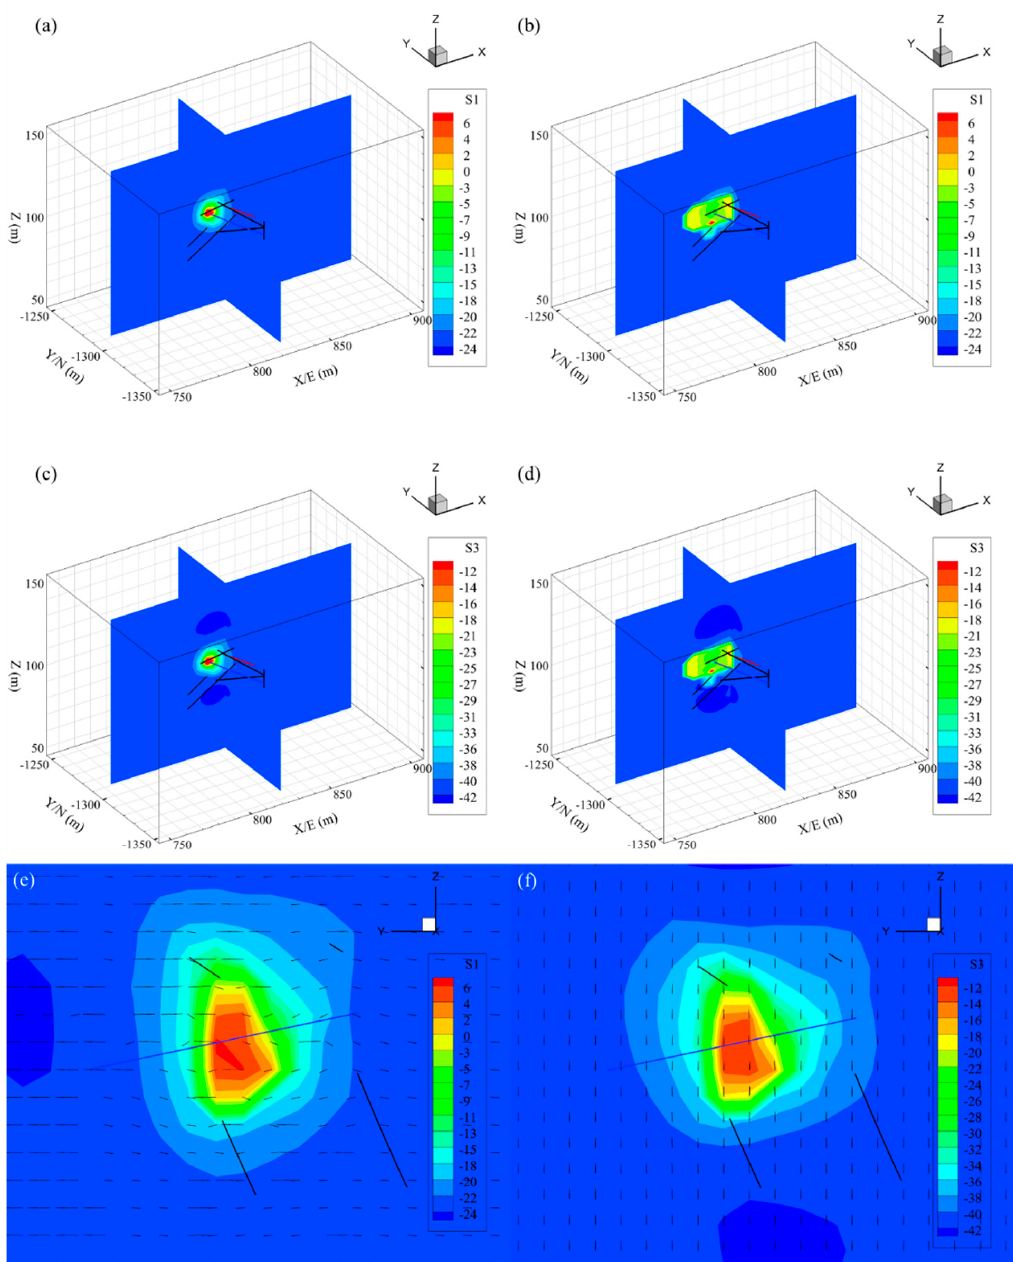
Figure 18. The evolution of the effective principal stress over time: ( a , b ) show the effective minimum principal stress distribution at T22:43 and T22:53, respectively; ( c , d ) show the effective maximum principal stress distribution at T22:43 and T22:53, respectively; ( e , f ) show the directions of the minimum principal stress and the maximum principal stress at T22:46.